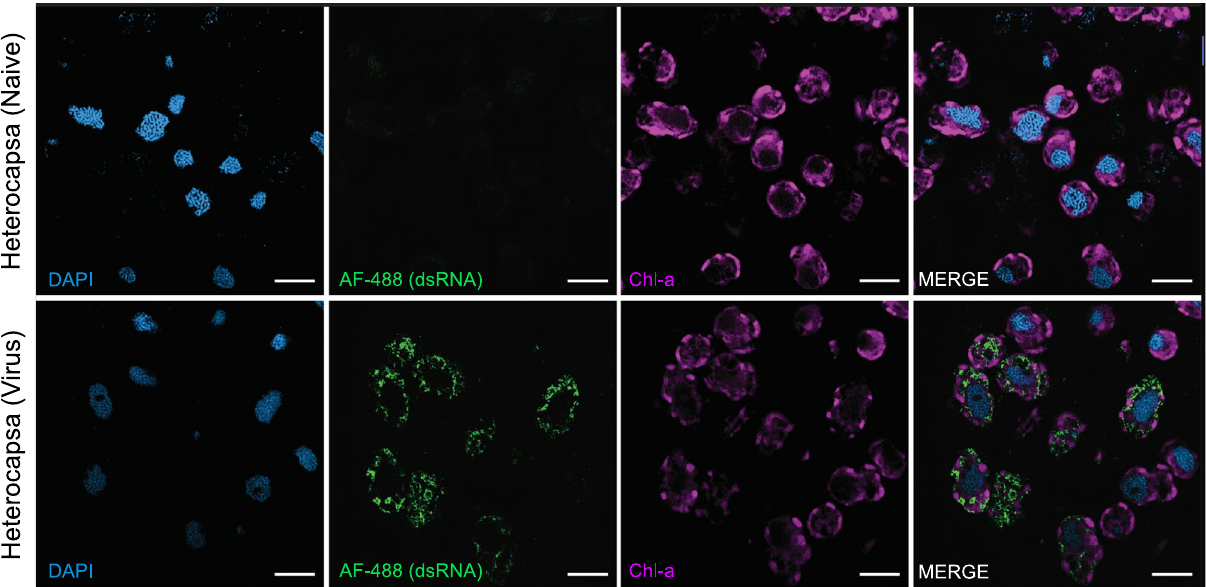
Figure 2. Airyscan, super-resolution imaging 16 h post-inoculation in 0.5 µm sections of Heterocapsa circularisquama naïve (top row) and HcRNAV-exposed (bottom row) samples. From left to right, columns indicate DAPI staining, AlexaFluor488 denoting dsRNA binding, chlorophyll-a autofluorescence, and merged images. Scale bars = 10